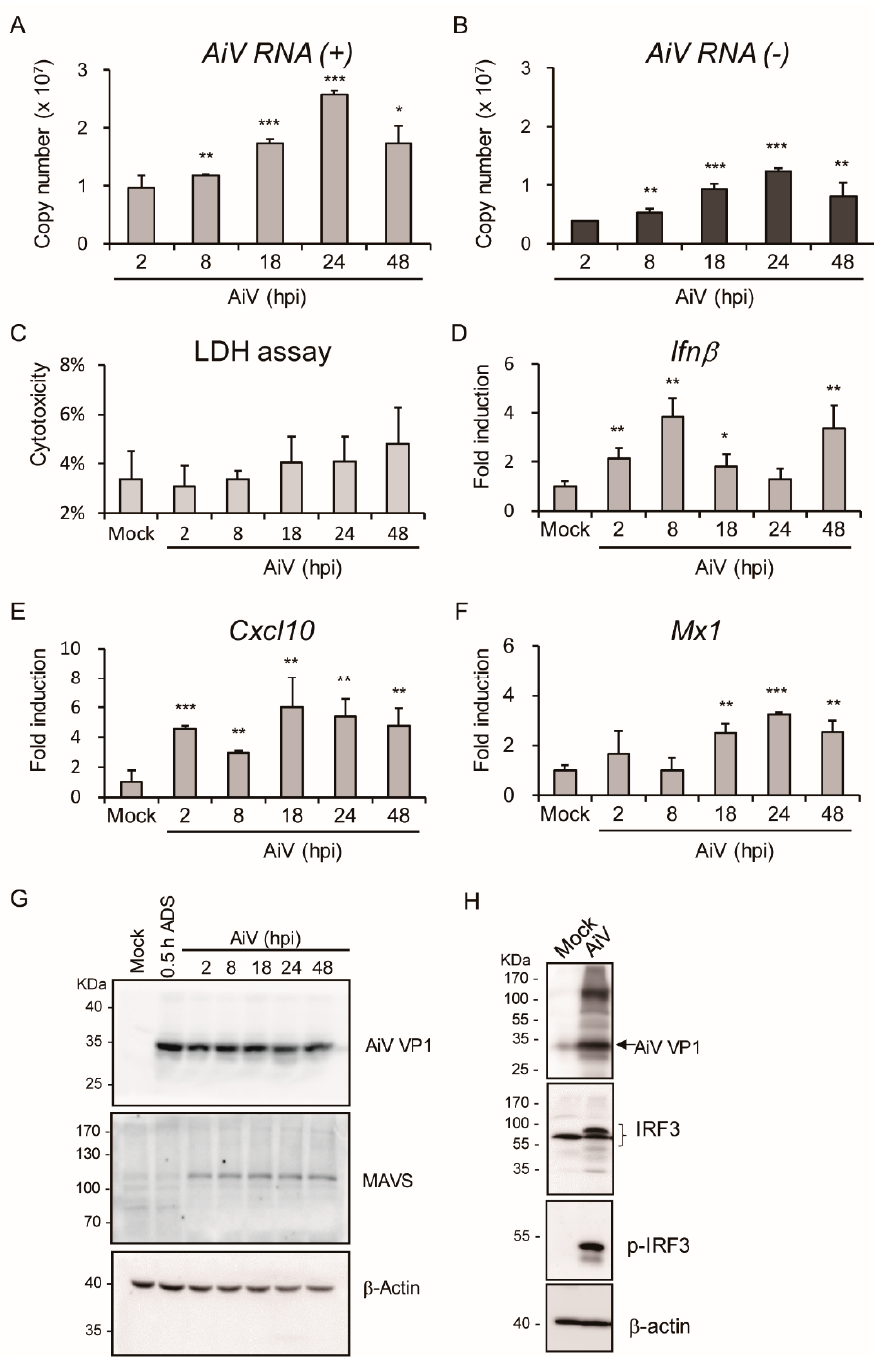
Figure 4. Kinetic analysis of AiV replication, cytotoxicity, and innate immune responses in IECs with AiV infection. ( A , B ) Absolute quantitation of dynamic viral genome copy number of AiV RNA ( + ) and (-) using RT-PCR with AiV VP1 ( + ) and (-) specific primers, respectively, in IECs (1 × 10 6 ) with AiV infection at MOI of 5 for 2–48 hpi. ( C – G ) IECs were infected as described above, and ( C ) LDH release measurement of AiV cytotoxicity of AiV performed and measured as cytotoxicity (%). ( D – F ) qPCR analysis of mRNA levels of Ifn β , Cxcl10, and Mx1 genes normalized to that of Gapdh . Fold induction was compared with mock. Data compared with 2 hpi AiV ( A , B ) or mock ( C – F ) showed as means ± SD ( n = 3). Student’s t -test *, p < 0.05; **, p < 0.01; ***, p < 0.001. ( G , H ) Western blot analysis of protein expression of AiV VP1, MAVS, phospho-IRF3, IRF3, and loading control β -actin in IECs with mock infection or AiV MOI 5 infection for 24 hpi or the indicated time course. ADS: adsorption.